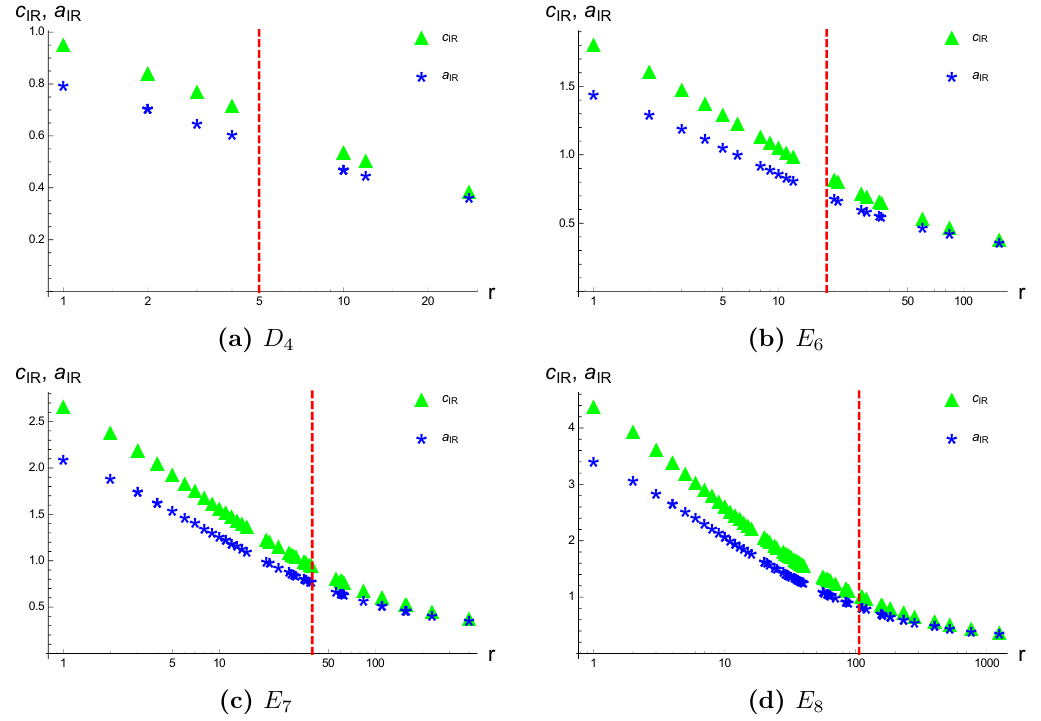
Figure 4. Plots of a IR (blue stars) and c IR (green triangles) vs embedding index r for the di(cid:11)erent probe D3-brane theories. The red vertical dashed line denotes the largest value of r before the Coulomb branch operator Z decouples. Anything to the right of this line has a single emergent U(1) to rescue the Coulomb branch operator. The plots are log-scaled on the x-axis for presentation purposes due to the fact that the region of deformed theories is denser around lower values of r and becomes more sparse as r